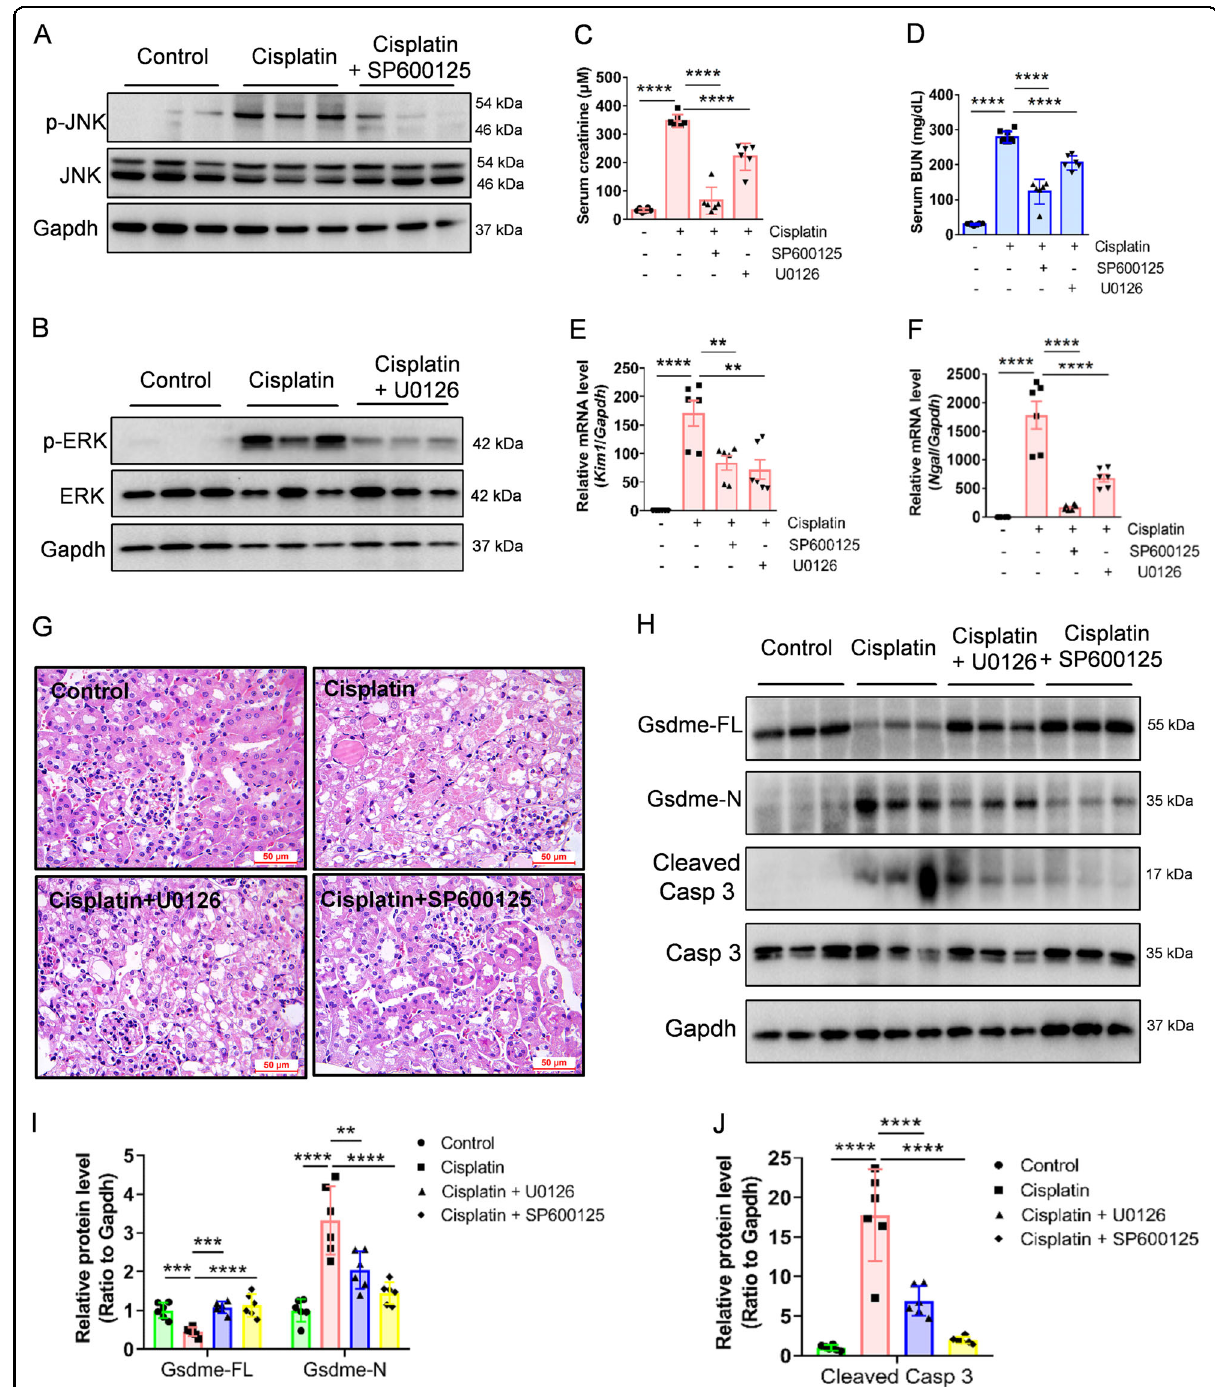
Fig. 7 U0126 and SP600125 alleviate cisplatin-induced renal pyroptosis in vivo. A , B Western blot analysis of ERK and JNK in kidney tissues from different groups. C , D Serum creatinine and BUN detected in cisplatin-treated mice before or after U0126 and SP600125 pretreatment. E , F mRNA expression of renal injury-related genes in kidney tissues from different groups. G Representative images of HE staining in kidney tissues from different groups. Scale bar, 50 μ m. H – J Western blot analysis of GSDME and caspase 3 in cisplatin-treated mice before, or after, Ac-DMLD-CMK pretreatment. All data are presented as mean ± SD from six independent experiments ( n = 6). ** p < 0.01, *** p < 0.001, **** p < 0.0001 using one-way ANOVA followed by the Tukey ’ s